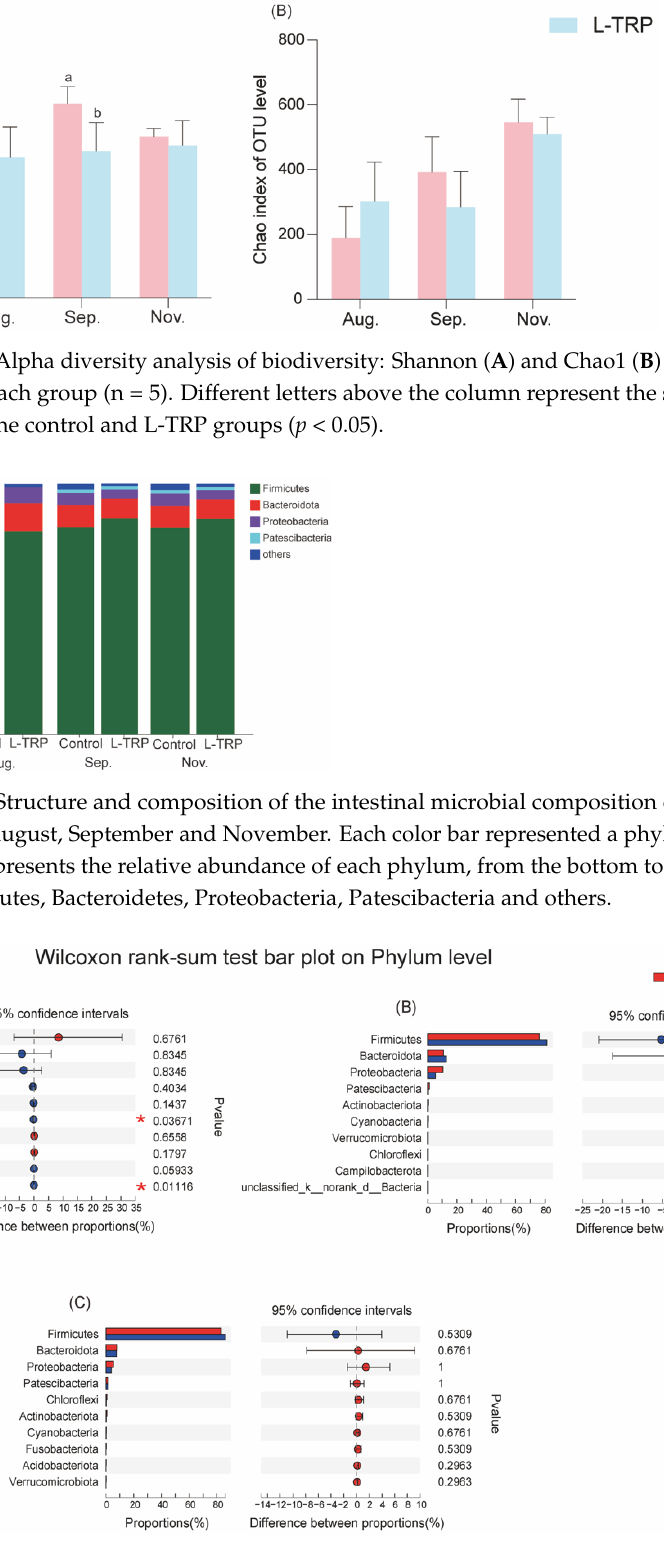
Figure 5. Alpha diversity analysis of biodiversity: Shannon ( A ) and Chao1 ( B ) richness and diversity index of each group (n = 5). Different letters above the column represent the significant differences between the control and L-TRP groups ( p < 0.05).